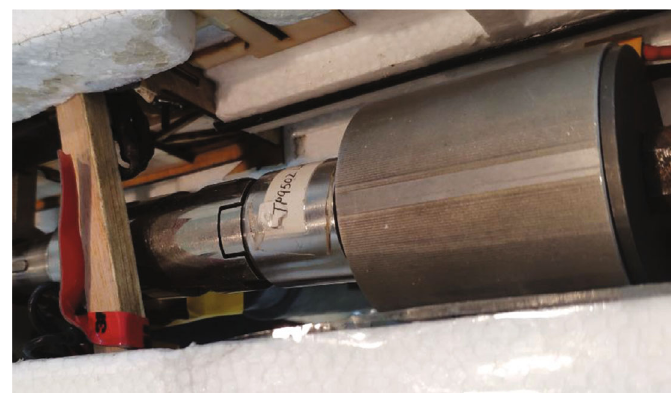
Figure 9: 9502 dynamic derivative